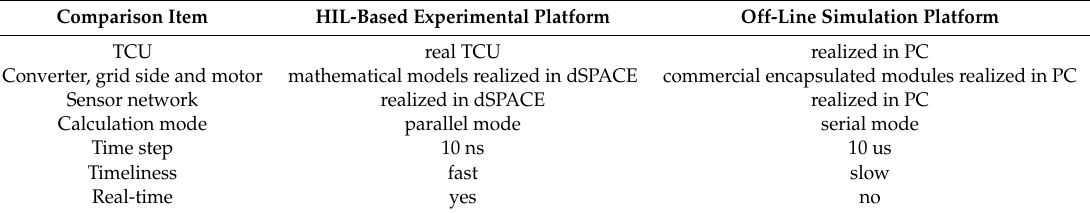
Figure 9. The relationship between different parts of the HIL-based experimental platform. Table 3. Comparison between off-line simulation platform and experimental